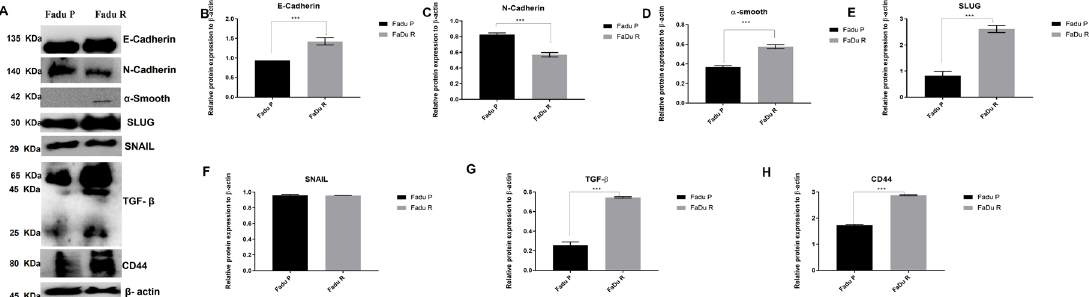
Figure 7. Epithelial–mesenchymal transition (EMT) markers expression in FaDu parental and FaDu resistant cells. ( A ) Representative images of EMT proteins detected in Western blot assay in parental and resistant cells. ( B ) E-cadherin densitometry. ( C ) N-cadherin densitometry. ( D ) α -smooth densitometry. ( E ) Slug densitometry. ( F ) Snail densitometry ( G ) TGF- β densitometry ( H ) CD44 densitometry Data are presented in fold-change in comparison with FaDu parental. Fadu p: FaDu parental; FaDu R: FaDu resistant. (*** p <